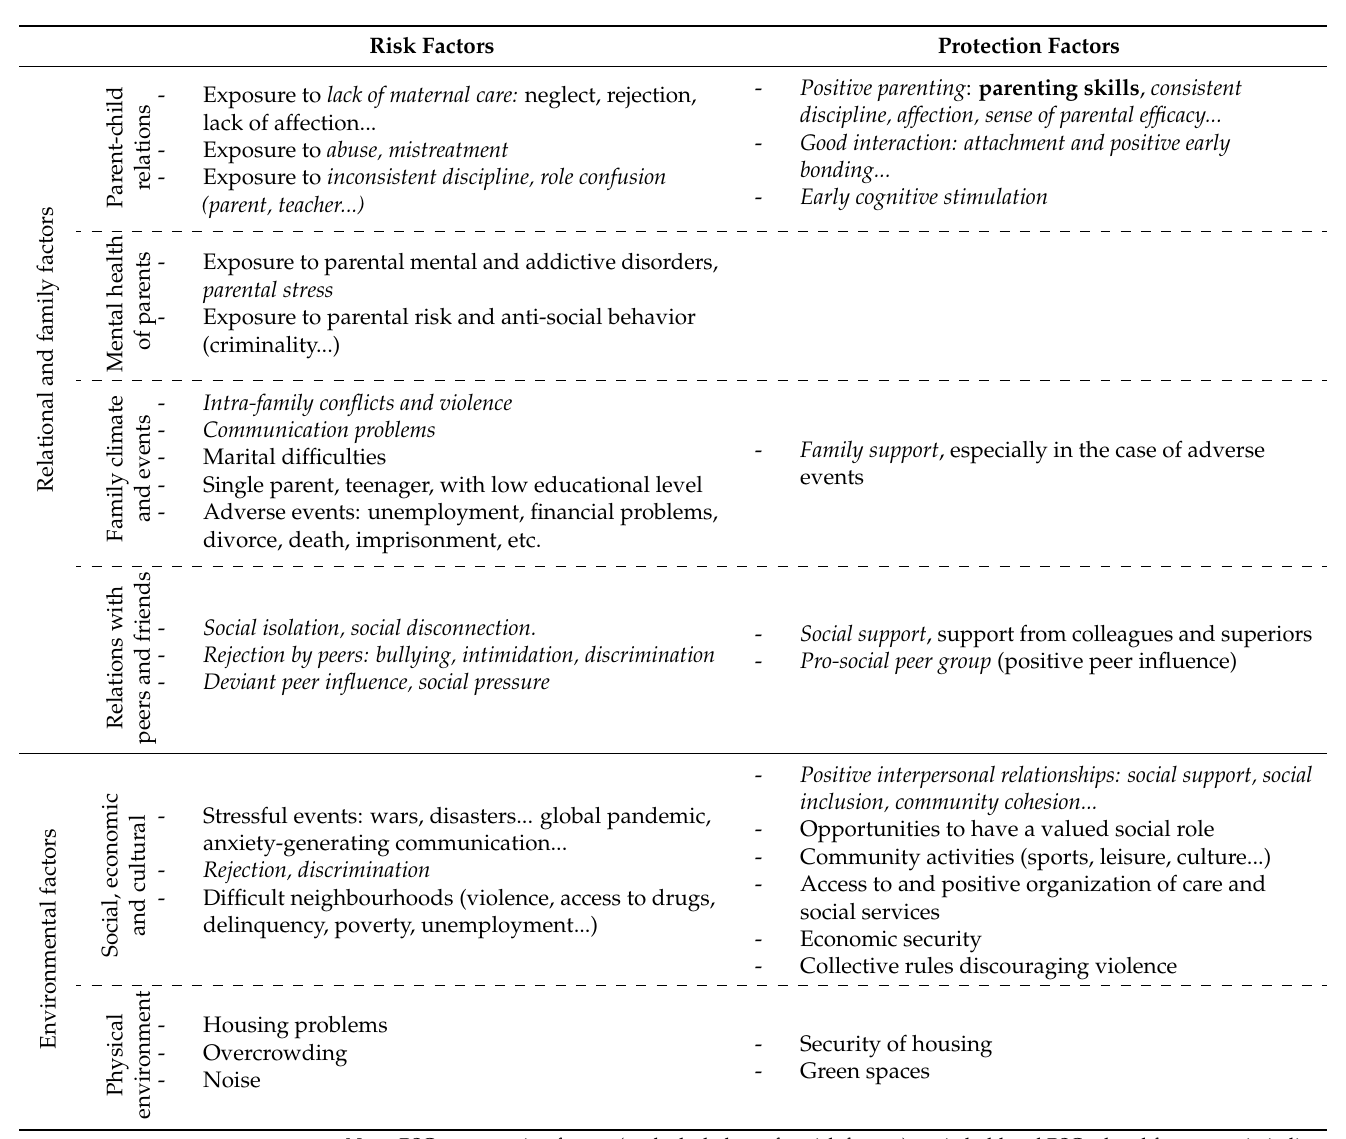
Table 1. Cont. Risk Factors Protection Factors